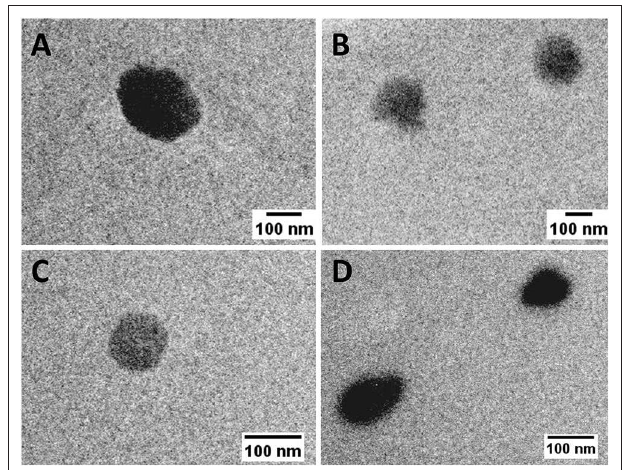
FIGURE 2 | TEM images of PLA NPs dispersed in pyrogen-free water (scale bar: 100nm). (A,B) PLA A NPs; (C,D) PLA B NPs.